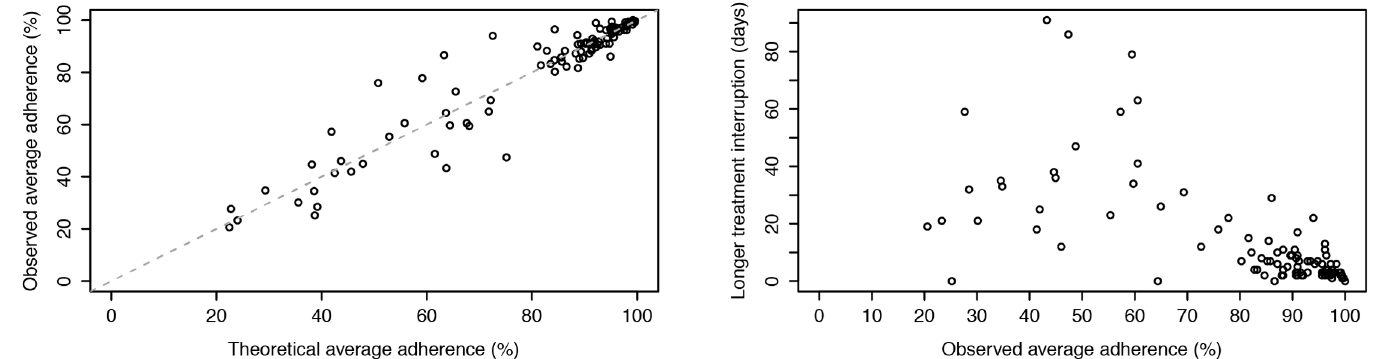
Fig 5. Simulated average adherence and treatment interruption duration. Left: Correlation between the theoretical average adherence and simulated observed average adherence, obtained with the first-order binary autoregressive adherence model, for a random sample of 100 hypothetical individuals followed for a 1-year time-period. Theoretical average adherence distribution: 30% with adherence below 80%; 20% with adherence between 80% and 90%; 50% with adherence above 90%. Right: Relationship between simulated observed average adherence and corresponding longer treatment interruption, for the same random sample.